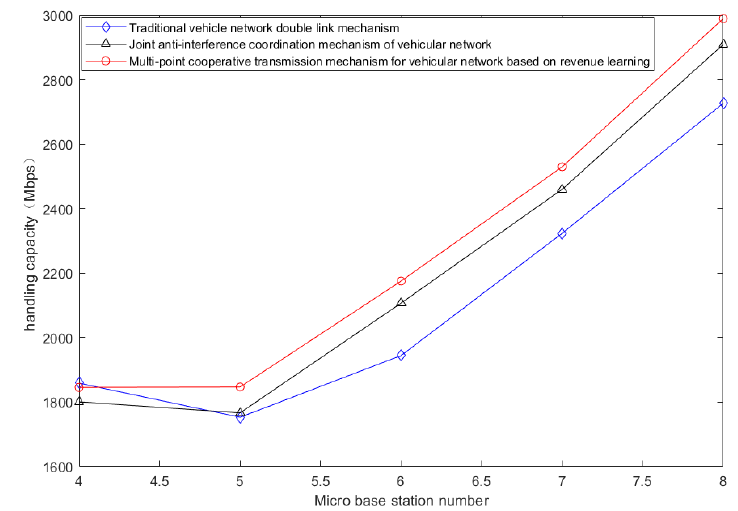
Figure 5. Comparison of system throughput under different policies.